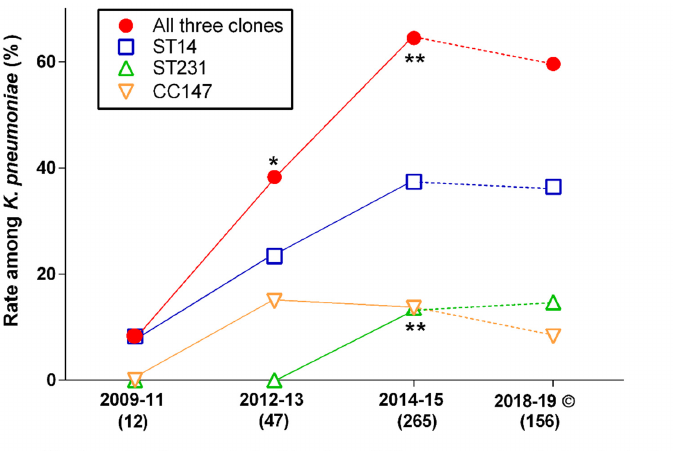
Figure 1. Changing the rates of major K. pneumoniae clones over time. Continuous line: current study period; dashed line: changes until the most recent data © [20]. * Significantly ( p < 0.05); ** highly significantly ( p < 0.01) different from previous point of time.